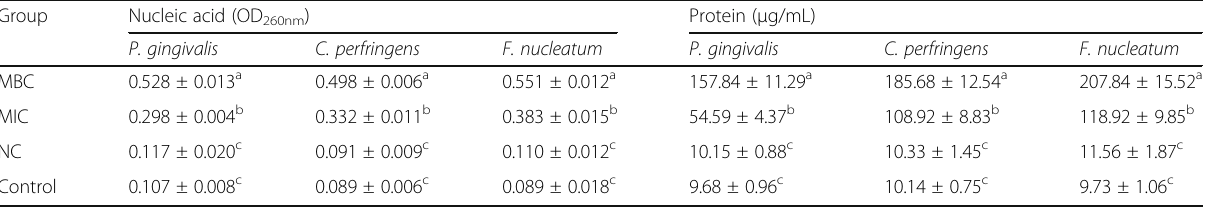
Table 4 Effect of ATS-80 on the nucleic acid and protein release of tested bacteria Group